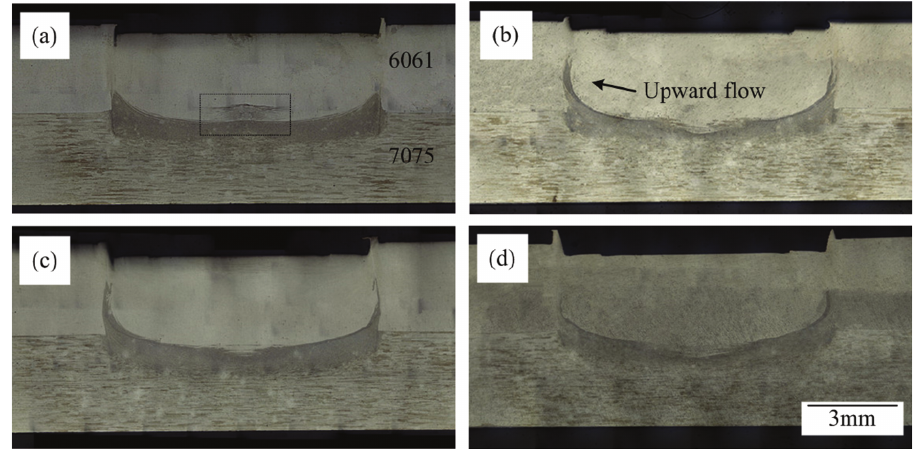
Figure 4: Joint cross sections using (a) 3.4mm, (b) 3.5mm, (c) 3.6mm and (d)